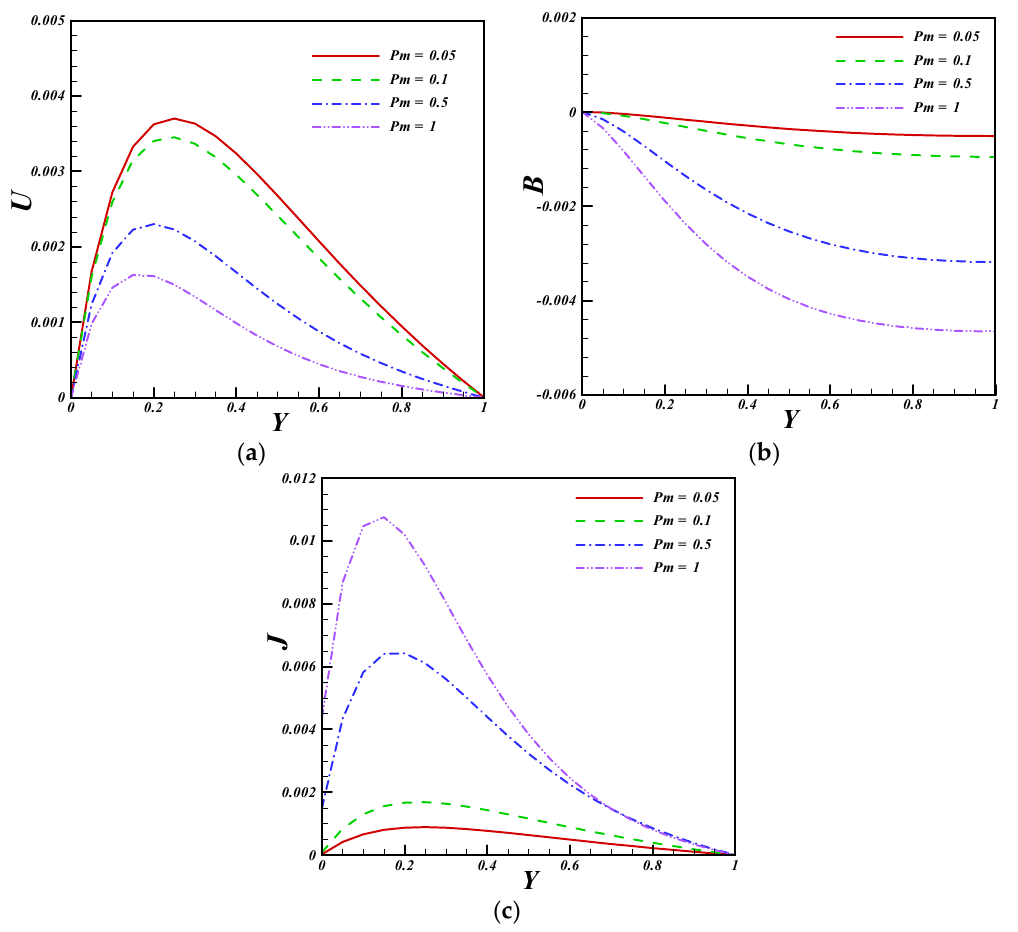
Figure 5. ( a ) Effect of magnetic Prandtl number (Pm) on velocity; ( b ) induced magnetic field; ( c ) induced current density distributions when V 0 = 1, Ha = 5, φ = 0.04, Pr = .